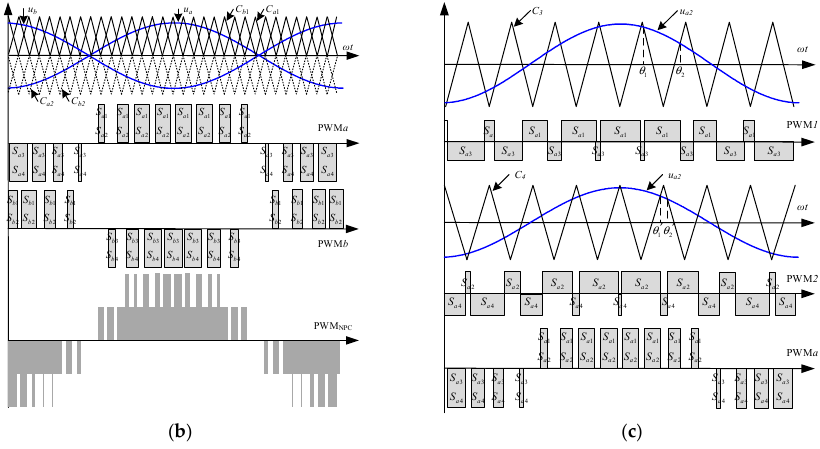
Figure 3. Modulation strategy. ( a ) Phase opposition disposition SPWM for one leg. ( b ) Carrier phase shifted with phase opposition disposition SPWM for NPC. ( c ) Big triangular carrier equivalence method.